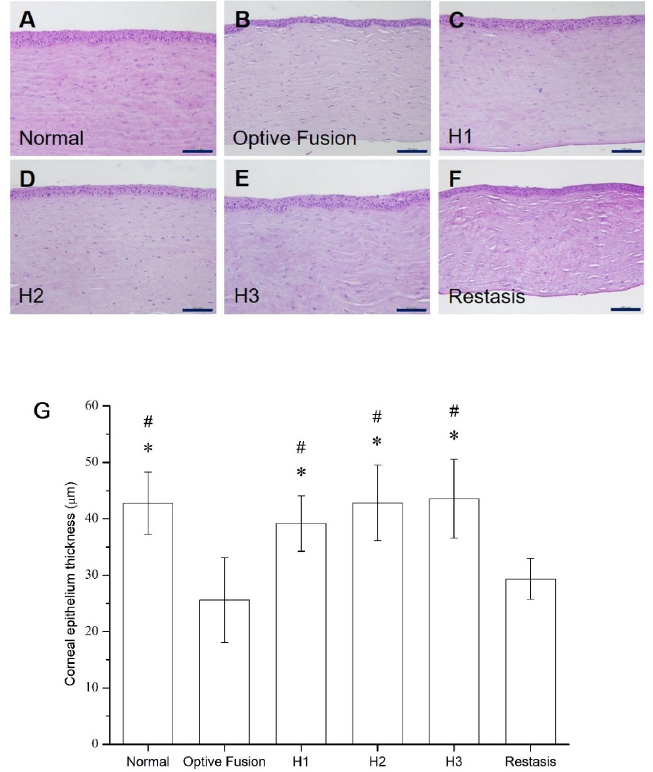
Figure 6. Representative images for histologic examination of the cornea on day 42 in the normal ( A ), Optive Fusion ® ( B ), H1 ( C ), H2 ( D ), H3 ( E ), and Restasis ® ( F ) groups. The corneal epithelial thickness was preserved in all groups except for the Optive Fusion ® and Restasis ® groups. ( G ) The average corneal epithelial thickness in each group by ImageJ analysis. The HA-nimesulide groups had preserved thickness, and significant differences were observed when compared with Optive Fusion ® (* p < 0.05) and Restasis ® ( # p < 0.05). Scale bar = 50 μm. The infiltration of inflammatory cells in the cornea was evaluated by CD11b immu- nofluorescence staining, which is a macrophage marker. As shown in Figure 7, no macro- phages infiltrated the cornea in the normal group, whereas CD11b-positive cells were pre- sent in the corneal stroma of the Optive Fusion ® group. Although the green fluorescence of CD11b appeared in the H1, H2, H3, and Restasis ® groups, the administration of HA- nimesulide conjugates and Restasis ® markedly reduced the extent of infiltration by CD11b-positive cells, which indicated that the HA-nimesulide conjugates might have a similar anti-inflammatory effect as Restasis ® .